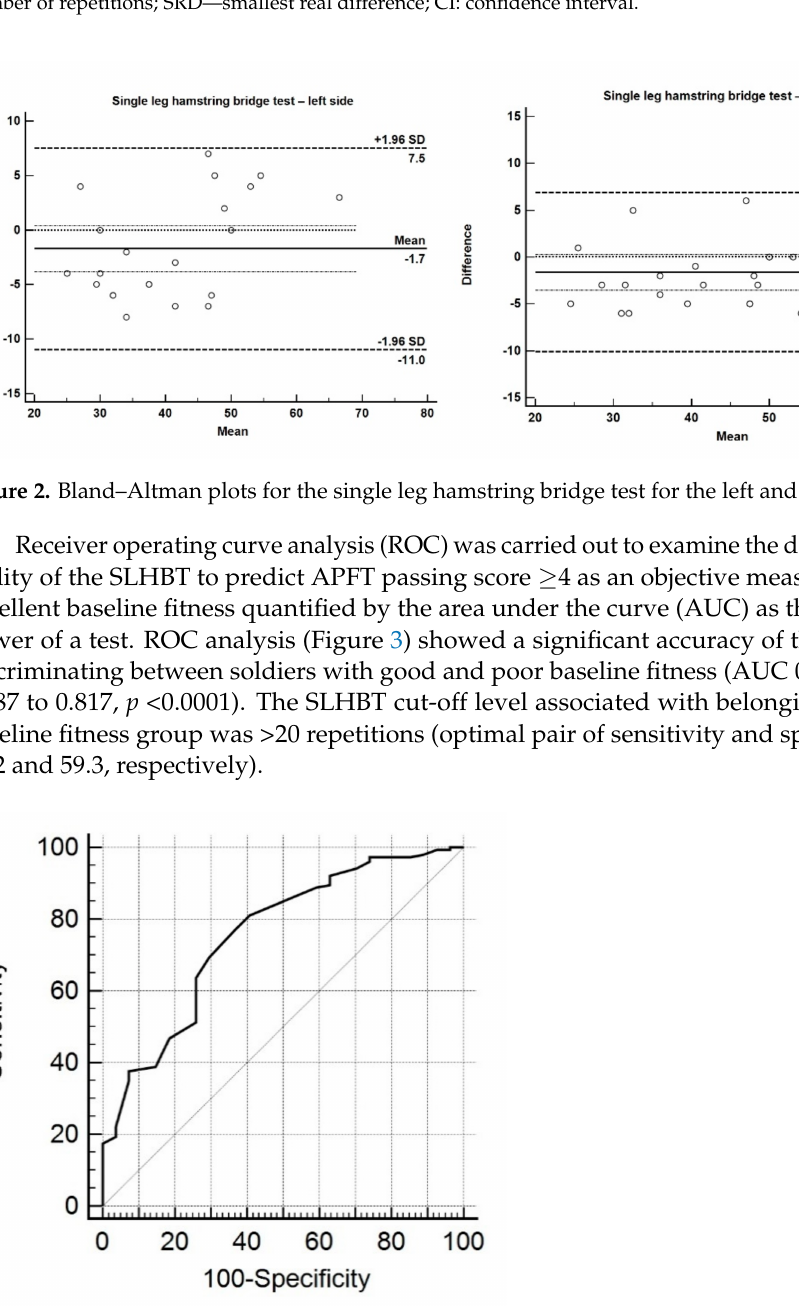
Figure 3. The receiver operating curve for predicting baseline fitness using the single leg hamstring bridge